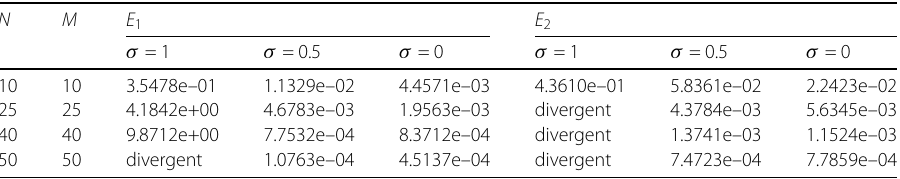
Table 1 Comparison of E 1 and E 2 , the maximum absolute errors, for different values of N , M in Example 1, when 0 < t ≤ 1